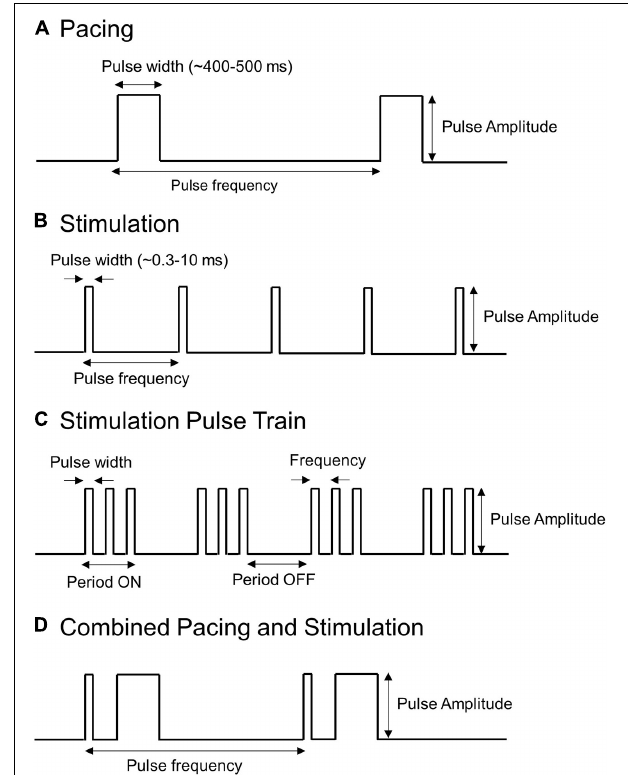
FIGURE 3 | Types of pulses used to stimulate or pace the stomach. Shown are (A) Long pulses associated with pacing (high-energy and low frequency), (B,C) Short pulses or trains of short pulses associated with stimulation (low energy and high frequency), and (D) a hybrid pacing and stimulation approach that combines short and long